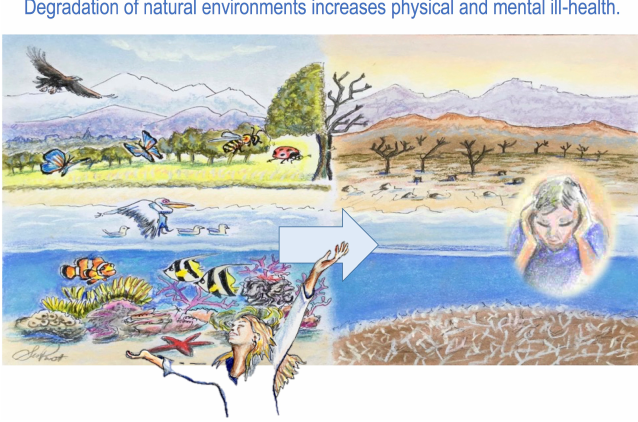
Figure 3. The health of humanity depends on the health of our environment. The physical and mental health consequences of environmental degradation should not be underestimated.